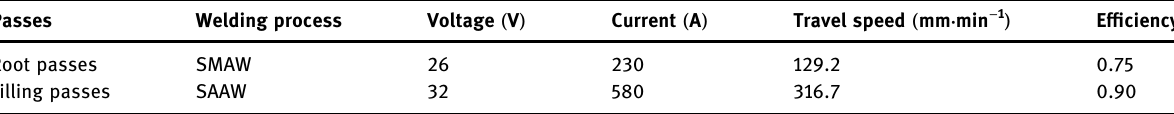
Table 2: Welding parameters during the SMAW and SAAW processes Passes Welding process